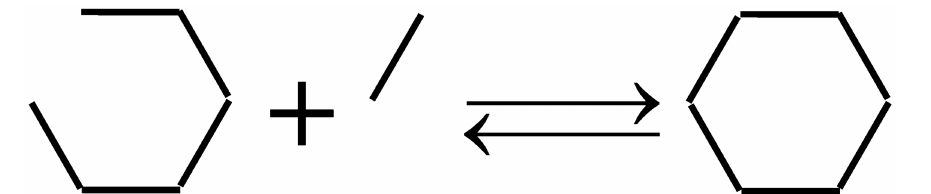
Fig 2. A cartoon to show the polymerization reaction of a monomer and a